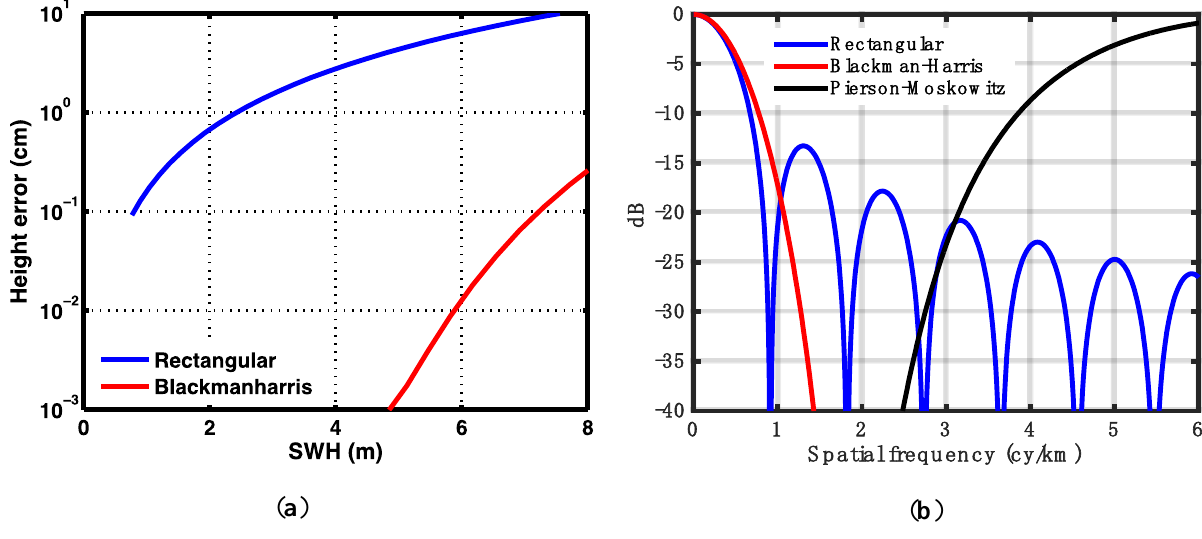
Figure 2. ( a ) Residual height error due to wave spectrum aliasing for rectangular (blue) and Blackman-Harris (red) windows as a function of SWH. ( b ) Spectral response for rectangular (blue) and Blackman-Harris (red) windows in comparison to ocean wave energy as predicted by a Pierson-Moskowitz wind driven spectrum (in black, normalized to maximum) for SWH = 3